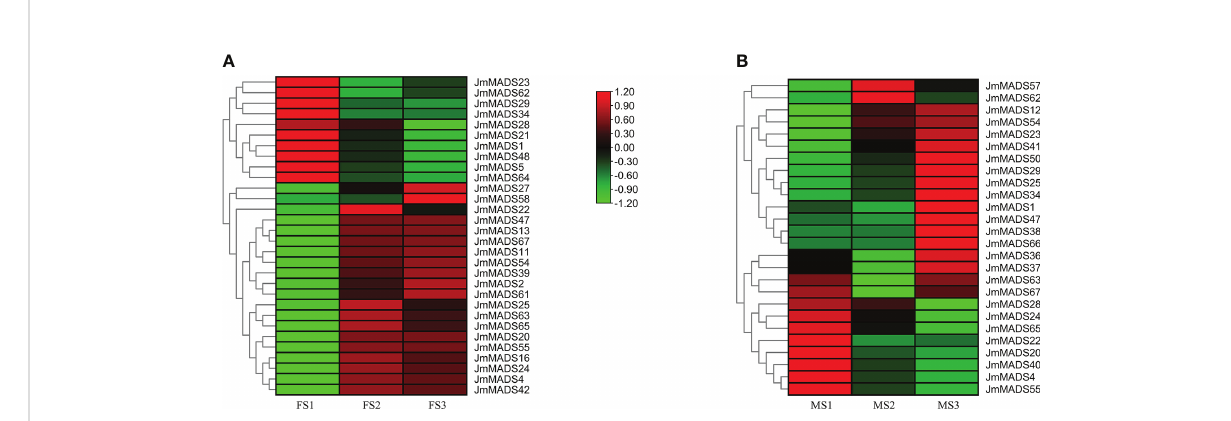
FIGURE 6 Expression patterns of JmMADS genes in different stages of fl oral organ development. (A) Heatmap of 30 JmMADS genes in female fl owers at the dormant bud (FS1), bud formation (FS2), and fl owering (FS3) stages. (B) Heatmap of 26 JmMADS genes in male fl owers at the dormant bud (MS1), anther formation (MS2), and anther maturation (MS3)